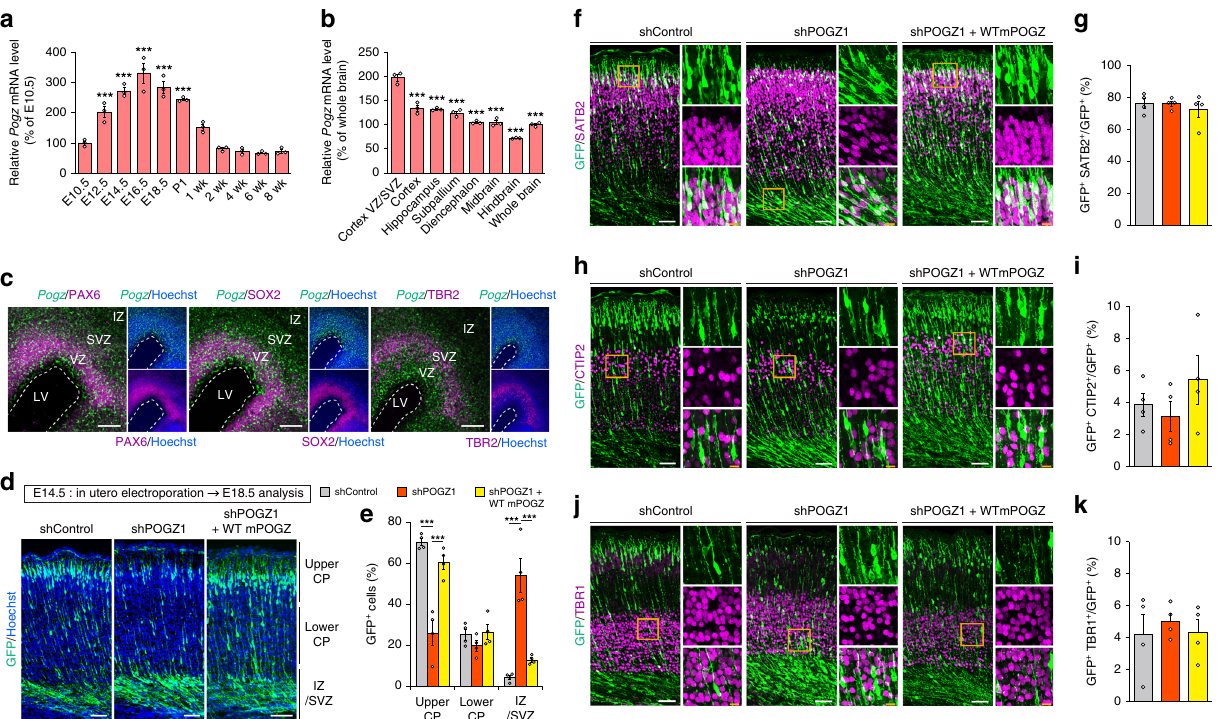
Fig. 2 POGZ regulates the mouse cortical neuronal development. a Temporal expression patterns of Pogz mRNA in the brain (each n = 3). E embryonic day; wk week-old. b Regional expression pattern of Pogz mRNA in the E16.5 brain (each n = 3). VZ ventricular zone; SVZ subventricular zone. c Fluorescence in situ hybridization of coronal sections of the E16.5 brain for Pogz and immunostaining with antibodies against PAX6, SOX2, and TBR2. Scale bars, 100 μ m. LV lateral ventricle; VZ ventricular zone; SVZ subventricular zone; IZ intermediate zone. d Impairment of neuronal migration by shRNA-mediated knockdown of Pogz in E18.5 mouse cortices electroporated at E14.5. CP cortical plate; IZ intermediate zone; SVZ subventricular zone. Scale bars, 50 μ m. e Quanti fi cation of GFP + cells in each layer (each n = 4). f GFP + neurons were co-labeled for SATB2 (a layer II/III marker). g Quanti fi cation of GFP + SATB2 + neurons ( n = 4). h GFP + neurons were co-labeled for CTIP2 (a layer V marker). i Quanti fi cation of GFP + CTIP2 + neurons ( n = 4). j GFP + neurons were co-labeled for TBR1 (a layer VI marker). k Quanti fi cation of GFP + TBR1 + neurons ( n = 4). Note that Pogz knockdown had little effect on the proportion of SATB2 + GFP + , CTIP2 + GFP + or TBR1 + GFP + neurons and that the GFP + cells with delayed migration were mostly SATB2 + neurons. h Same slice as in f . f , h , j Right panels, magni fi cations of the areas outlined with orange boxes. White scale bars, 50 μ m; orange scale bars, 10 μ m. a , b , g , i , k One-way ANOVA with Bonferroni – Dunn post hoc tests; a F 10, 22 = 48.52; b F 7, 16 = 73.23; g F 2, 9 = 0.393; i F 2, 9 = 1.079; k F 2, 9